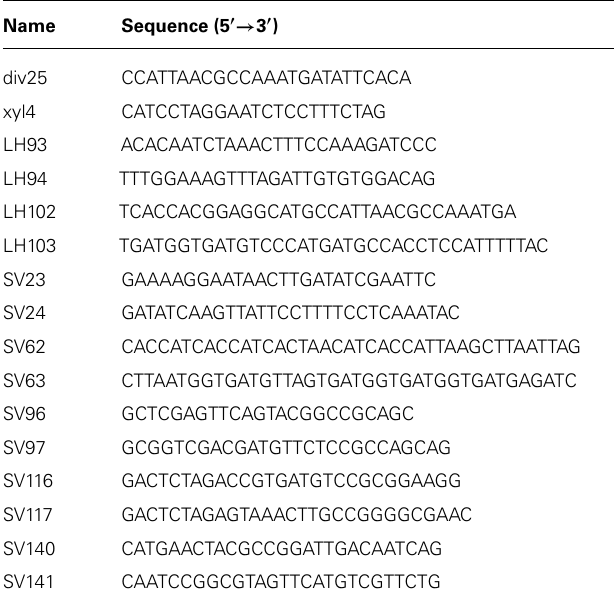
Table 2 | Oligonucleotides used in this